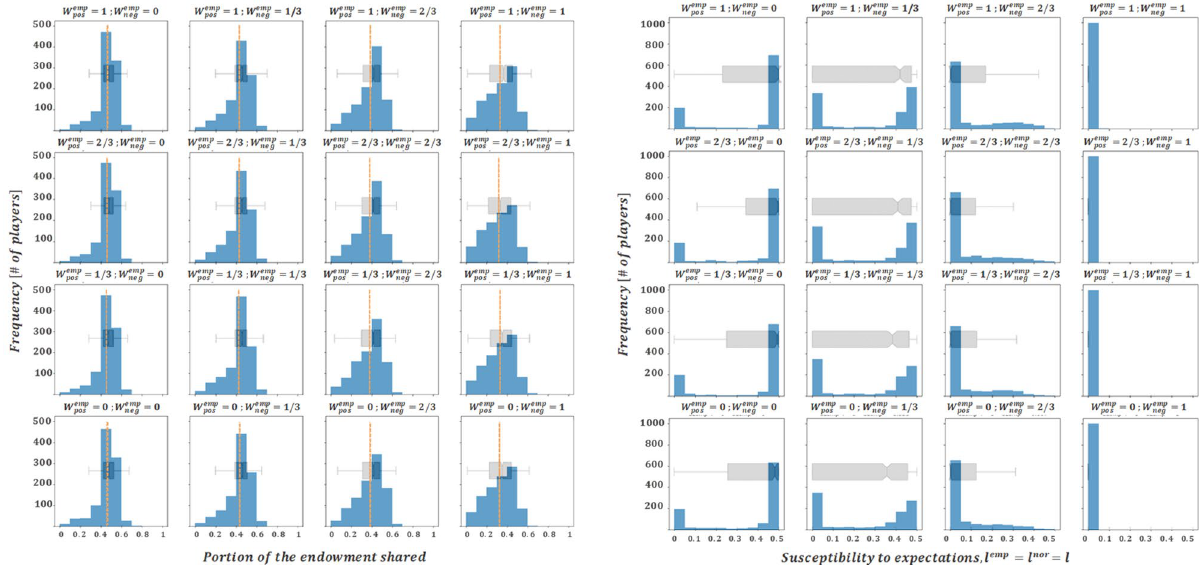
Figure 5. Final averaged distributions of donations and susceptibility profiles for W nor = 1 and = l emp l nor i , t . Each subplot represents results for a given combination of the remaining impact levels, i , t W emp , pos ( whichvariesacrossrows ) and W emp , neg ( whichvariesacrosscolumns )